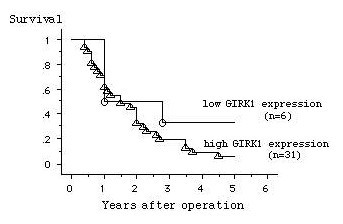
Survival curves of the patients with stage II / III NSCLC on the basis of GIRK1 amplification. A significant difference was not seen between the 2 groups.